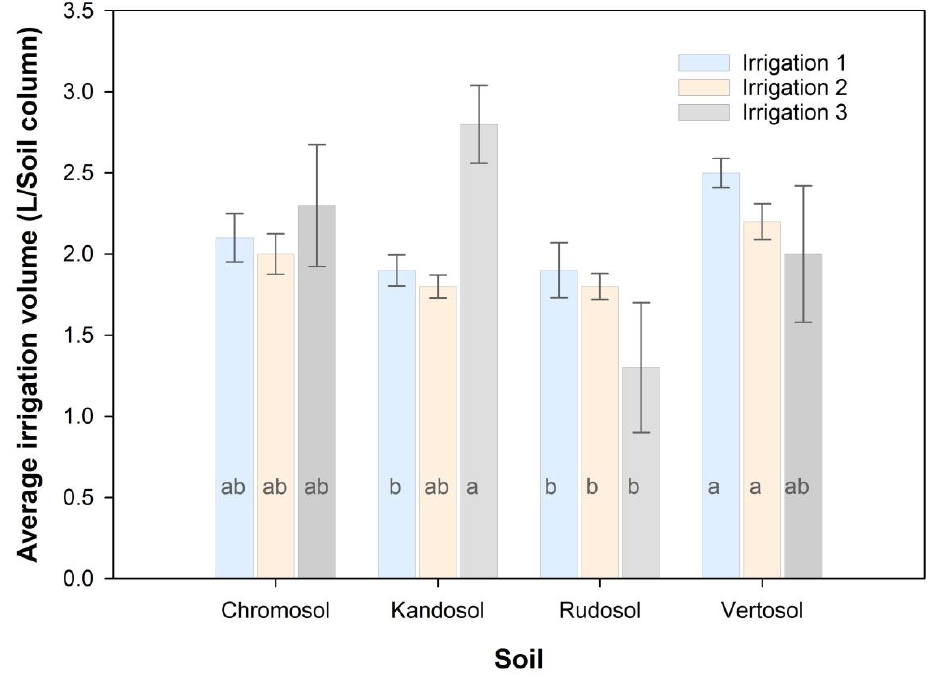
Figure 2. The average volume of irrigation applied to lysimeter columns to generate an equal volume of leachate. Error bars represent standard error. Different letters represent significant differences between treatment means. Bars sharing the same letters are not significantly different within each soil type at α = 0.05.